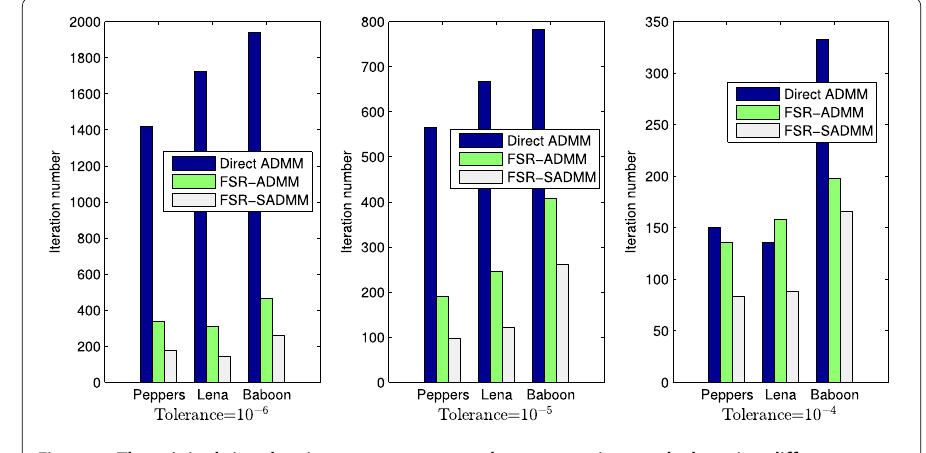
Figure 4 The original signal, noisy measurement, and reconstruction results by using different methods.